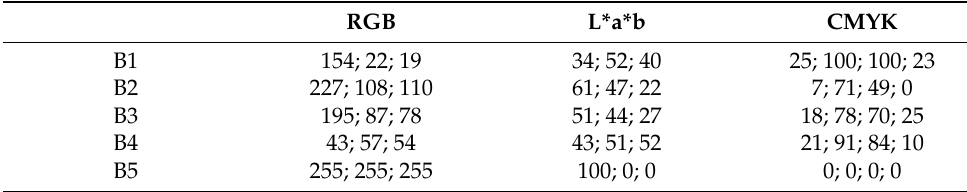
Figure 1. Dye shades used in the study. Table 1. Characteristics of the used dyes (before the laser procedure). Table 1. Characteristics of the used dyes (before the laser